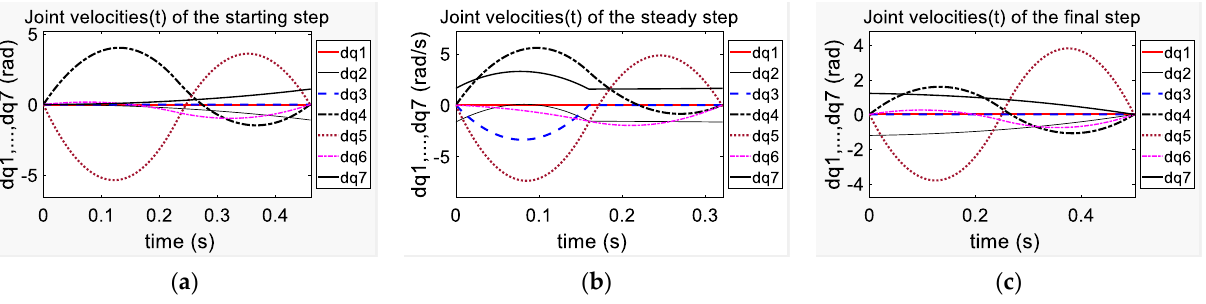
Figure 7. The motion of robot link: the joint coordinates (t) in the starting ( a ), steady ( b ), and final ( c ) steps.